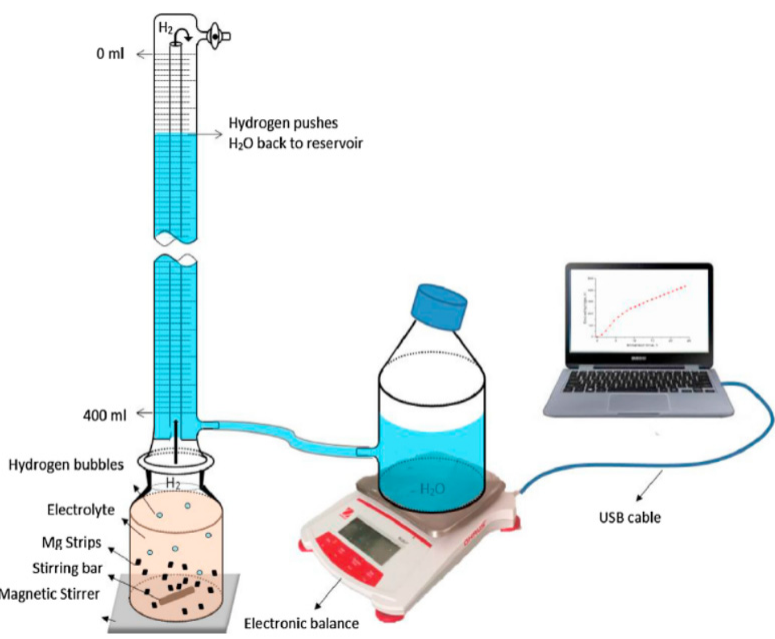
2 sensor area [35].